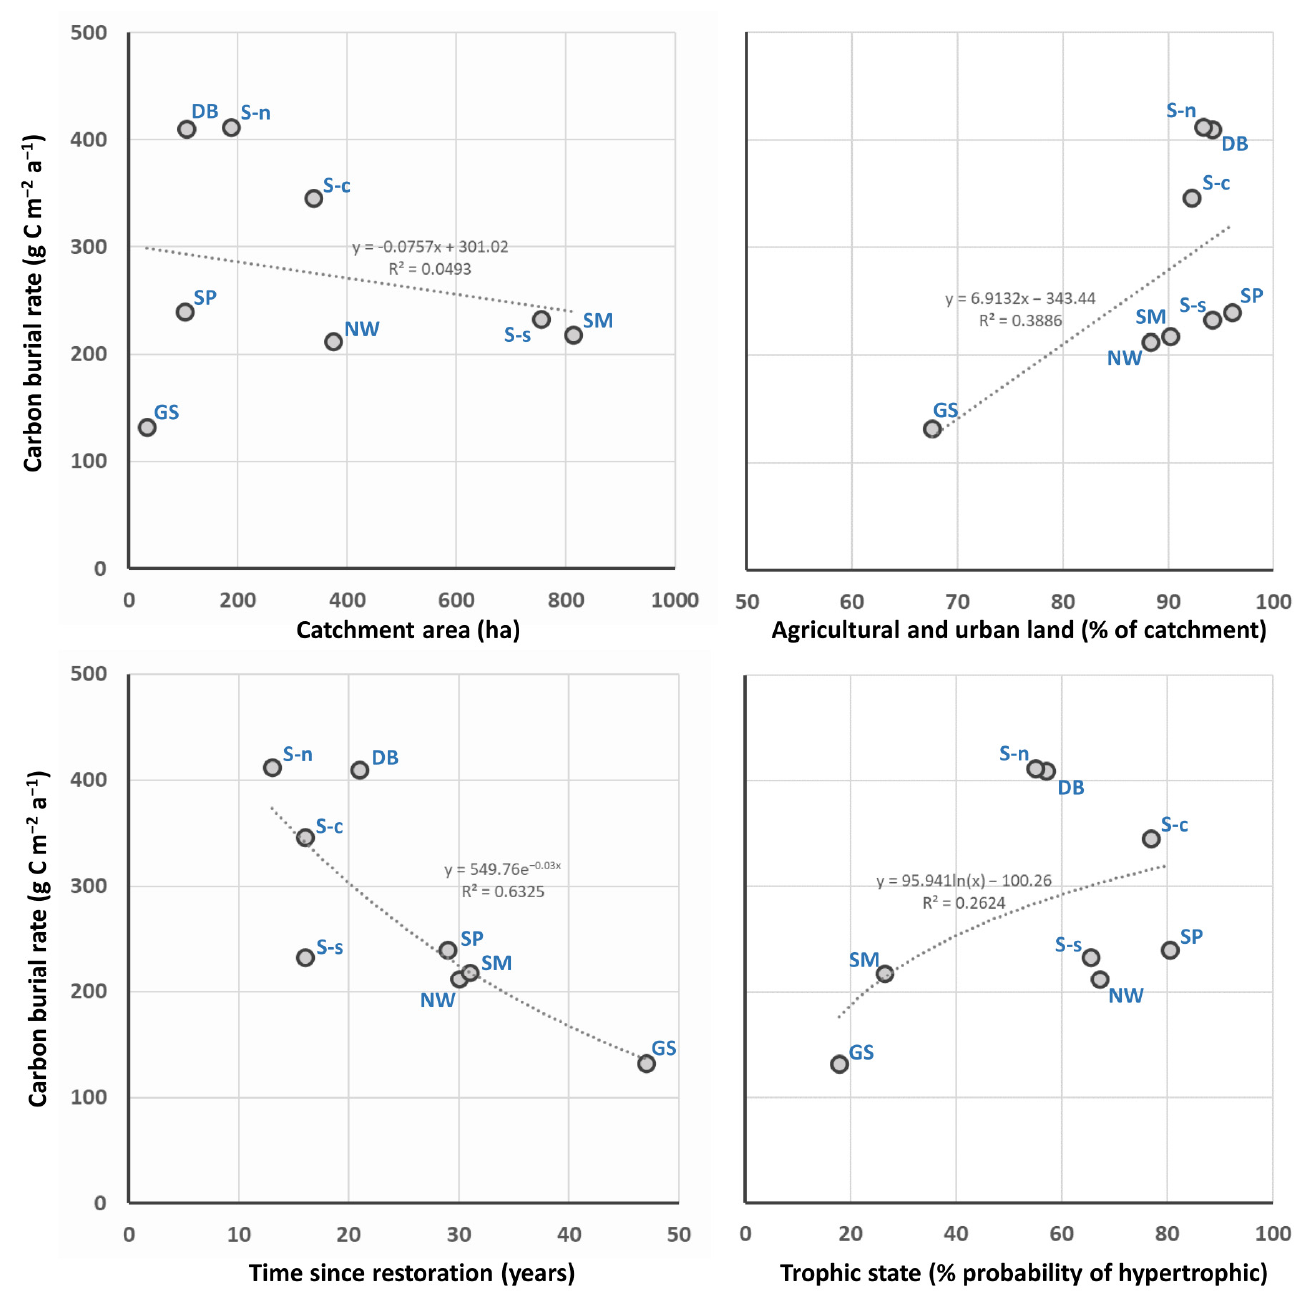
Figure 3. Relationships between indicators characterising the studied lakes and level of matter accumulation in their sediments; Lake denotations: GS—G ą siorowskie; NW—Nowe W ł óki; SM— S ę talskie Ma ł e; DB—Dobr ąż ek; SP—S ę tal Pond; S-n—Saw ą g (northern part); S-c—Saw ą g (central part); S-s—Saw ą g (southern part).